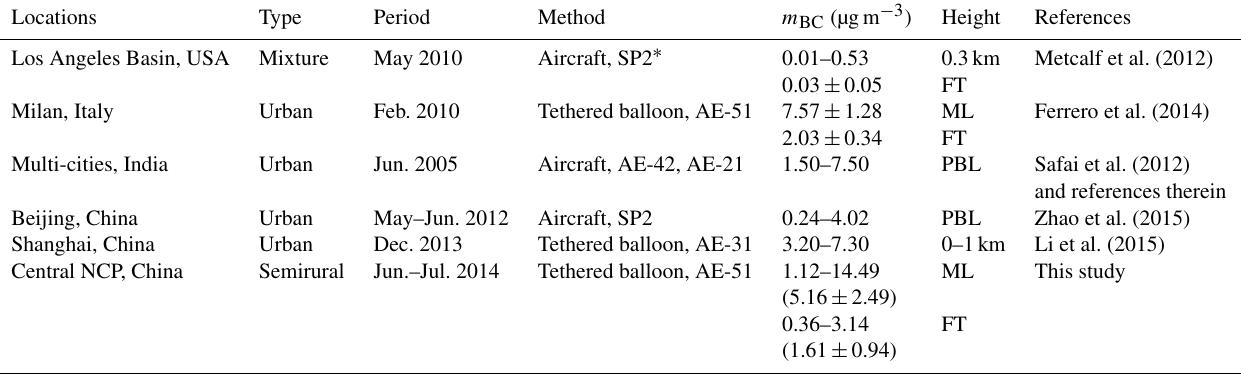
Table 3. Measurements of BC vertical distributions in different regions. m BC is the range and/or average value ± standard deviation of BC mass concentrations, depending upon what is available in the literature. Height specifies how m BC is